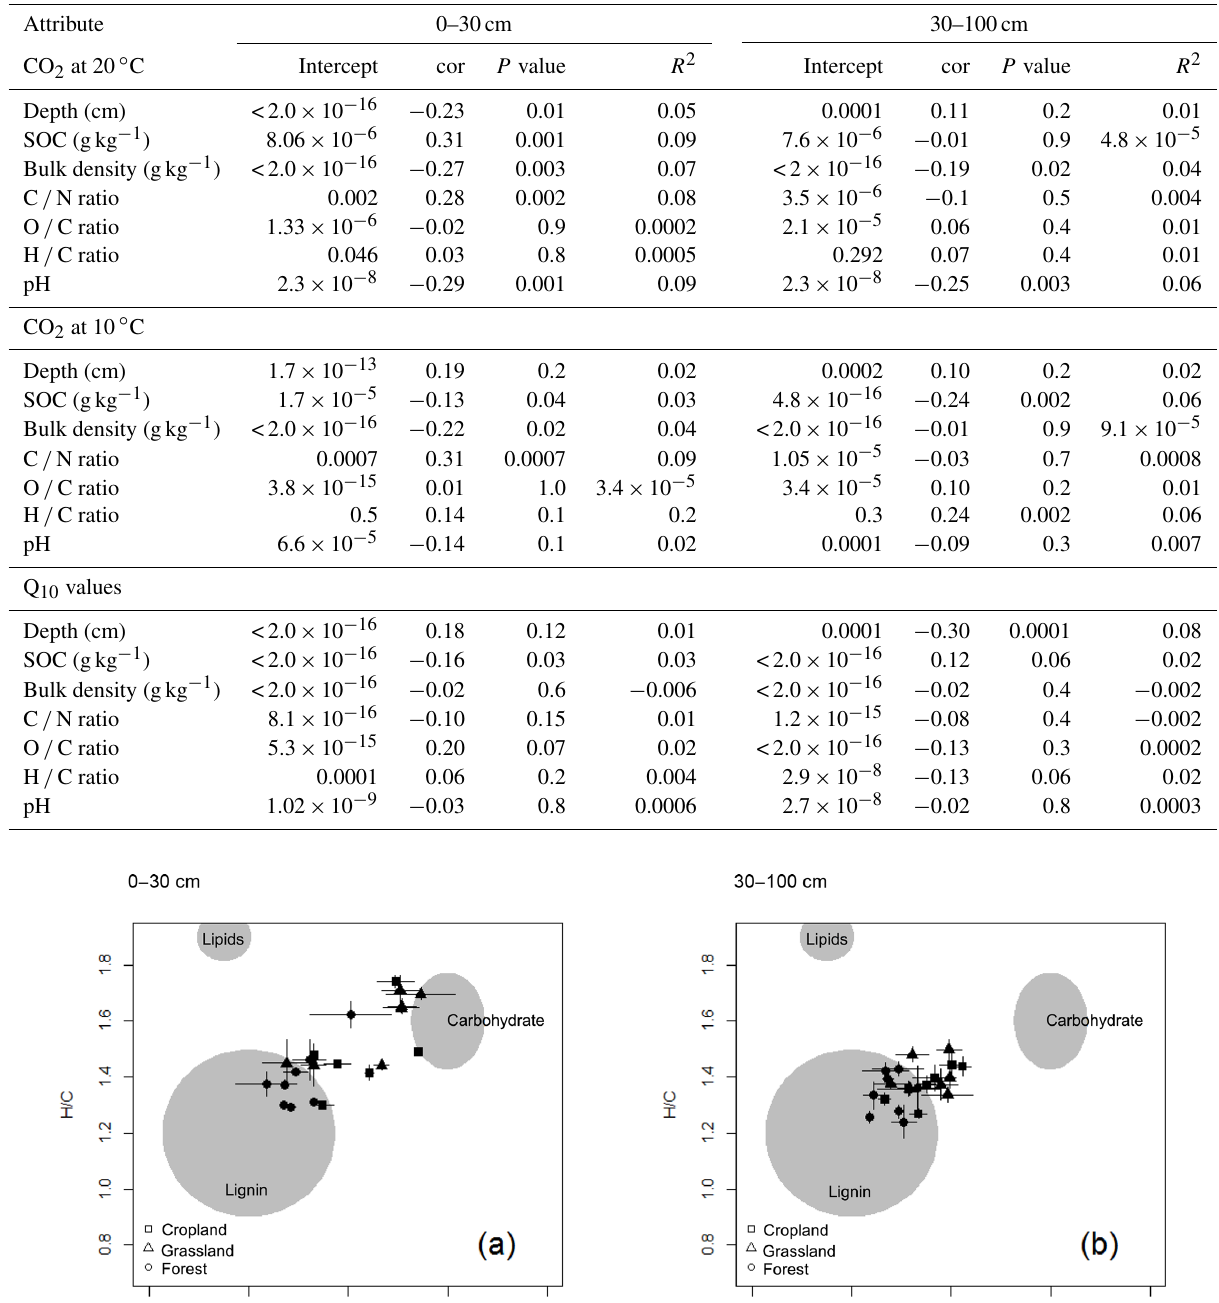
Table 4. Coefficients of determination and correlation for CO 2 emissions measured at 20 ◦ C and different soil attributes as explanatory variables (profile depth, SOC content, bulk density, C / N, O / C and H / C ratio). Ea values (not shown) behaved similarly to Q 10 values.